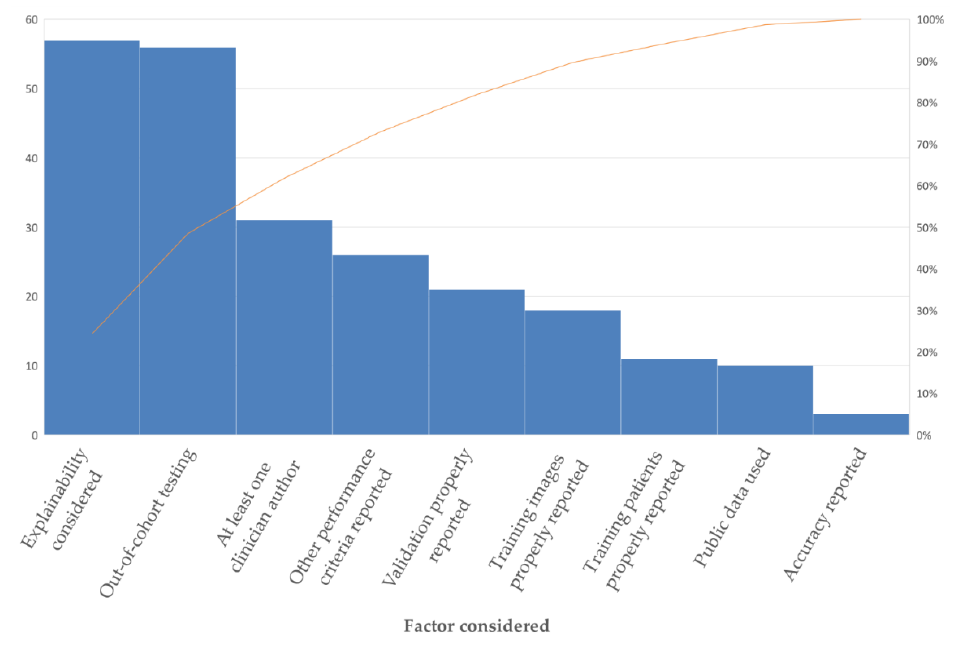
Figure 14. Histogram (left scale) and cumulative distribution (right scale) of factors not fully reported or considered in the studies reported in Table 4.